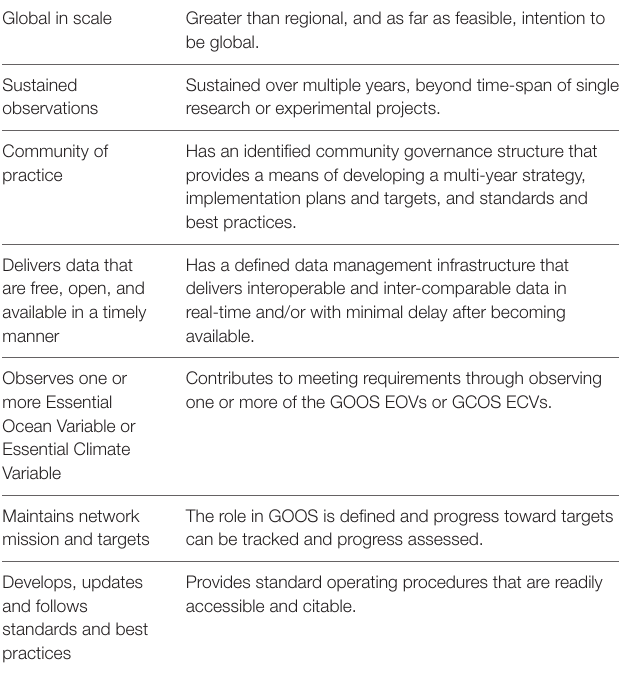
TABLE 2 | Attributes of a JCOMM